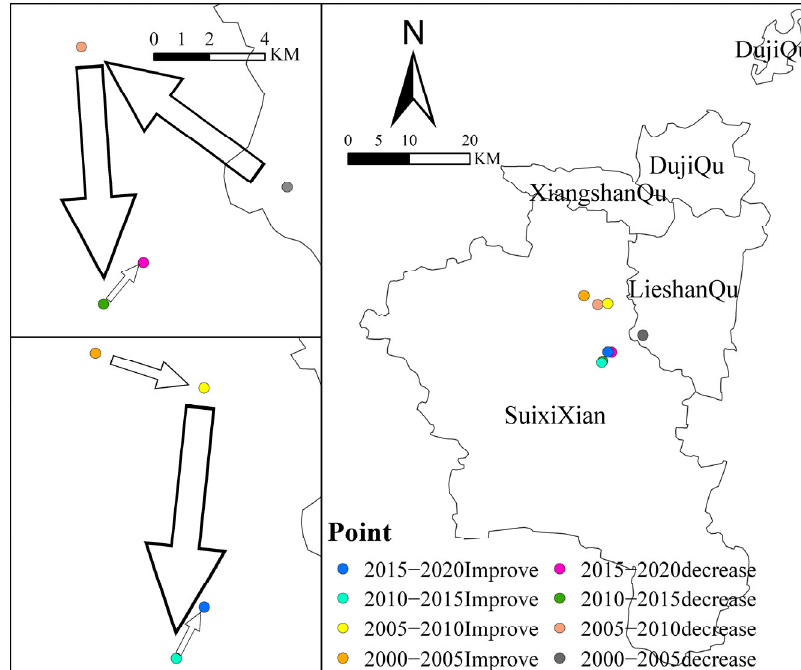
Figure 7. The barycenter migration map of the RSEI change curve in Huaibei City.